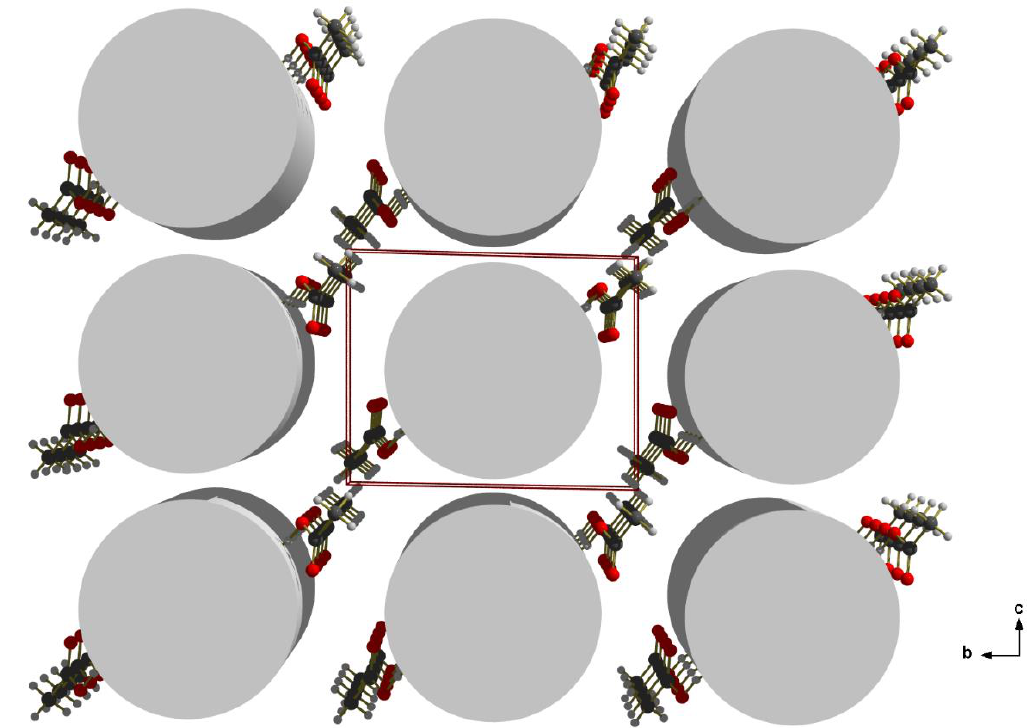
Figure 10. Arrangement of the one-dimensional coordination polymers (simplified visualized as rods) in the crystal structure of the RE(OAc) 3 · 2AcOH structure type, looking down the a-axis; example RE = Nd. Uncoordinated, but hydrogen bonded acetic acid molecules filling the space between the rods in a zipper-like manner are shown as ball-and-stick model.